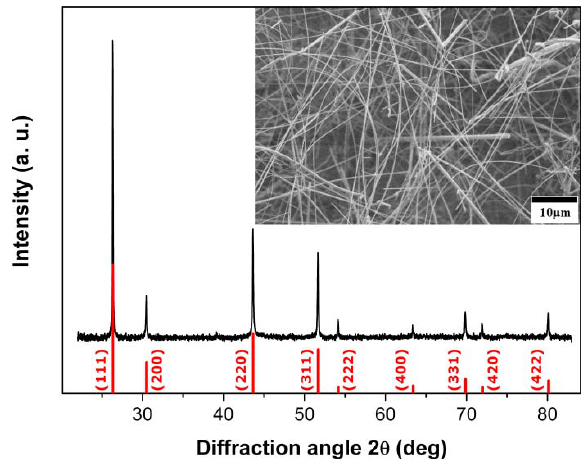
Figure 1. Representative X-ray diffraction (XRD) pattern and scanning electron microscope (SEM) image (inset) of zinc blende (ZB)-type indium phosphide (InP) wires deposited on a Si substrate at 440 °C (reference pattern: ICSD